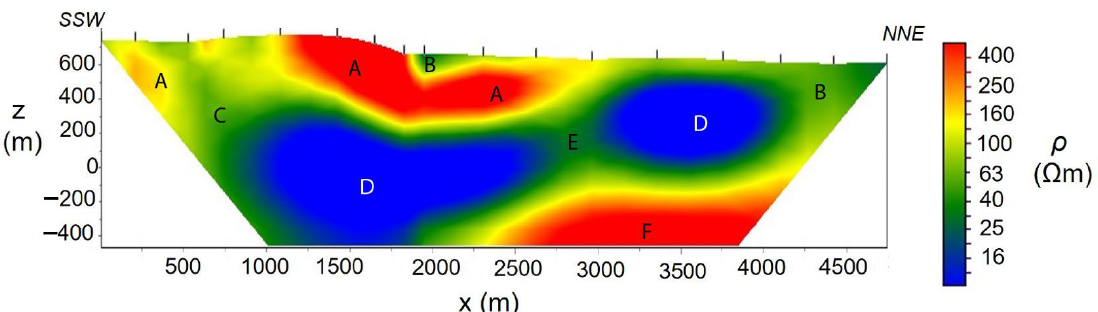
Figure 9. DERT results. The capital letters identify areas with different resistivities, whose values are shown in the resistivity bar ( ρ in Ωm). A is the resistivity zones with ρ > 120 Ωm ; B and C rep- resent resistivity zones with 30 < ρ < 100 Ωm ; D have resistivity value < 30 Ωm ; these low-resistivity bodies are separated with a higher-resistivity domain E with ρ > 50 Ωm ; F has resistivity values ρ > 150